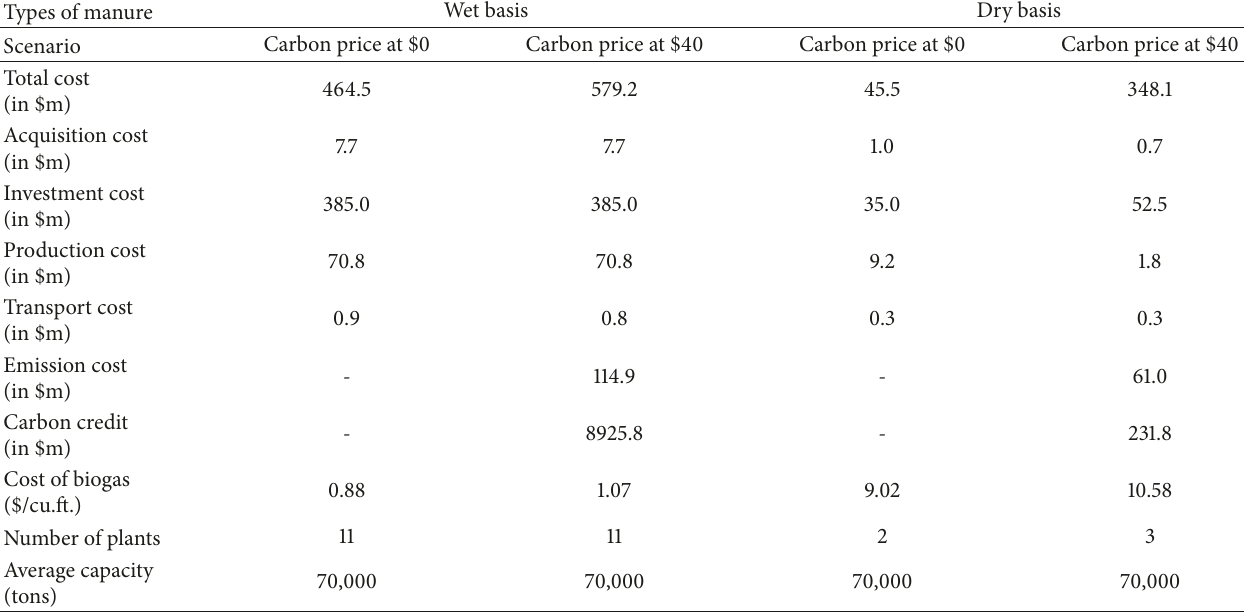
Table 6: Impact of wet versus dry manure